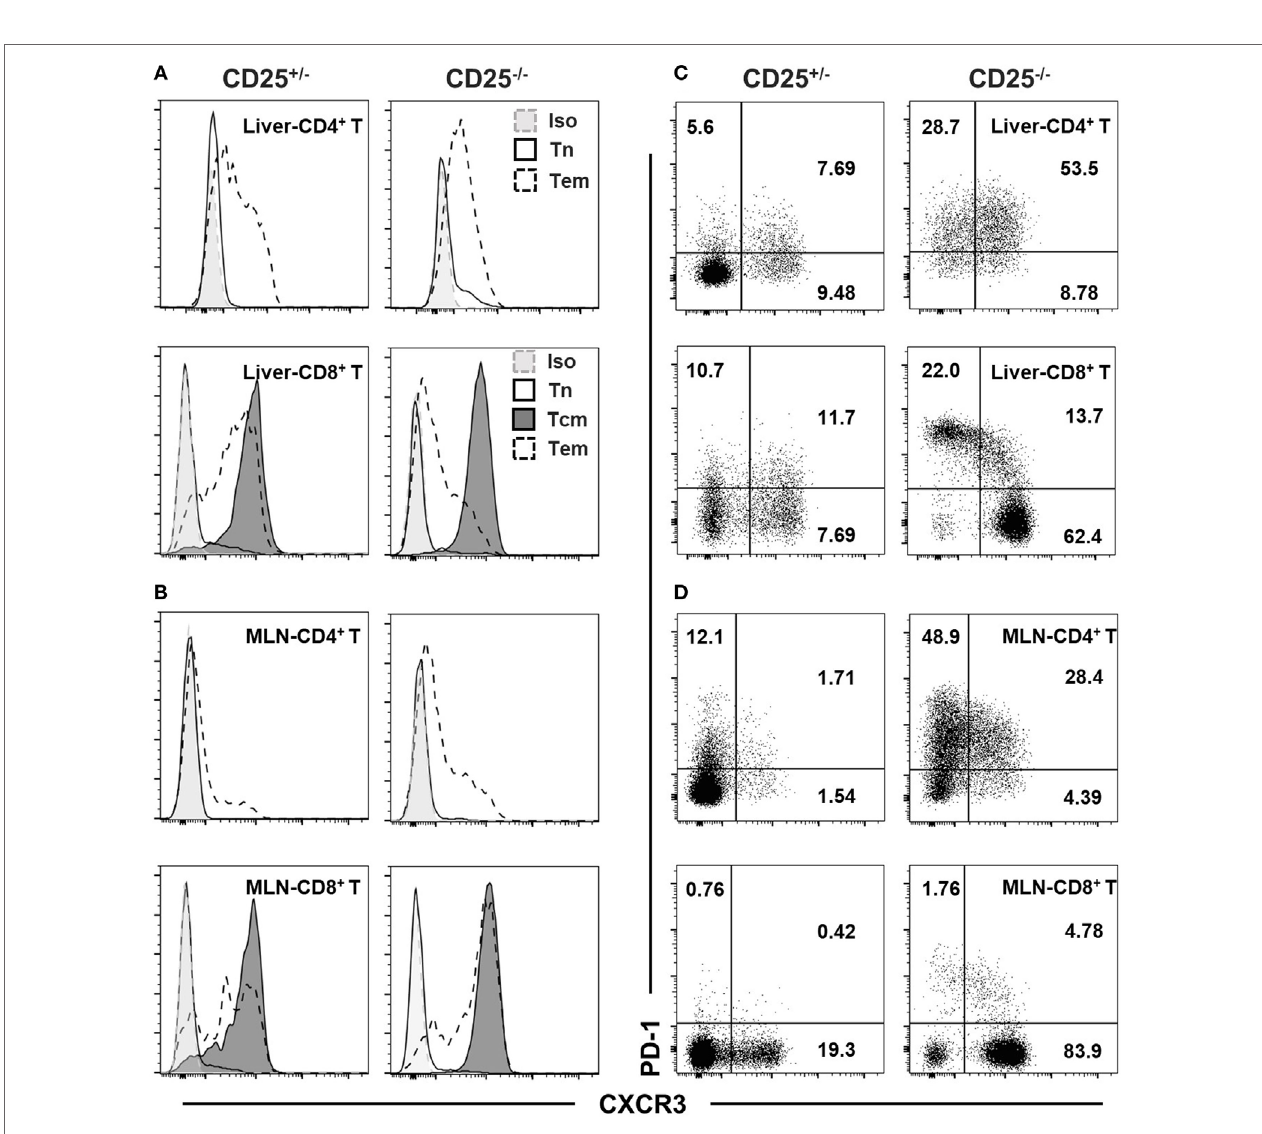
FigUre 2 | CXC chemokine receptor 3 (CXCR3) and PD-1 phenotypes of T cell subsets in CD25 − / − mice and their CD25 + / − littermates. Expression of CXCR3 on naïve T (Tn, CD62L + CD44 − ), central memory T (Tcm, CD62L + CD44 + ), and effect memory T (Tem, CD62L − CD44 + ) cells among hepatic (a) and mesenteric lymph node (MLN) (B) CD4 + T and CD8 + T cells were examined by flow cytometry. CD4 + Tcm were not examined due to their low frequency. The expression patterns of CXCR3 and PD-1 in hepatic (c) and MLN (D) CD4 + T and CD8 + T cells were also compared between CD25 + / − and CD25 − / − mice. At least five mice in each group were examined and generated data similar to the representative results shown in this figure.